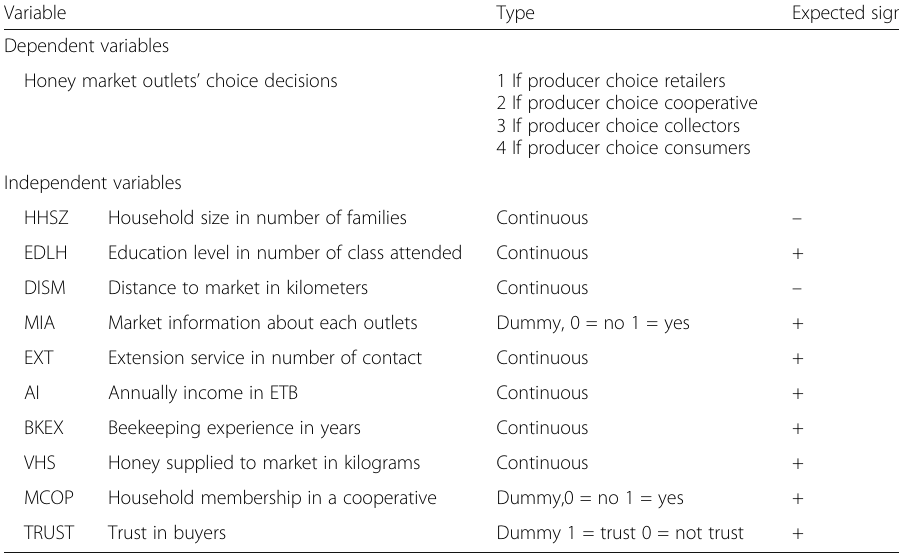
Table 1 Summary of hypothesized variable that determines honey producers ’ market outlet choices Variable Type Expected